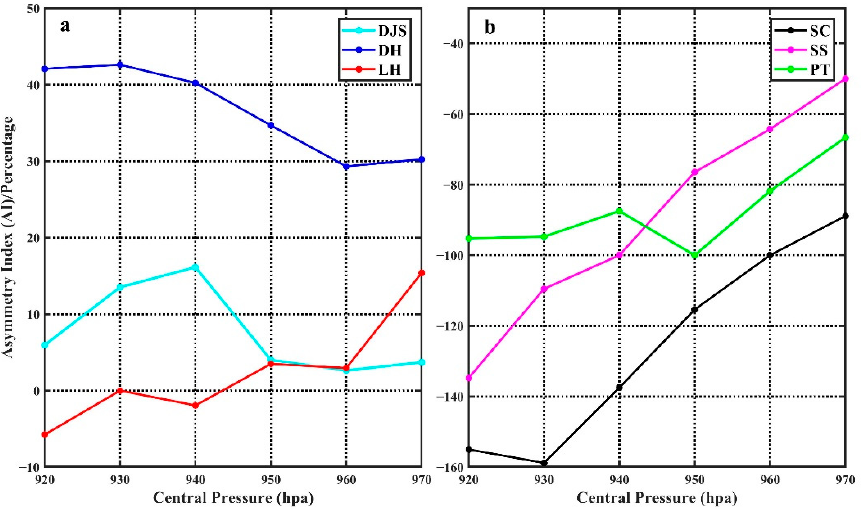
Figure 10. The relationship between asymmetry index and central pressure at: ( a ) DJS, DH, and LH stations; ( b ) SC, SS, and PT stations.